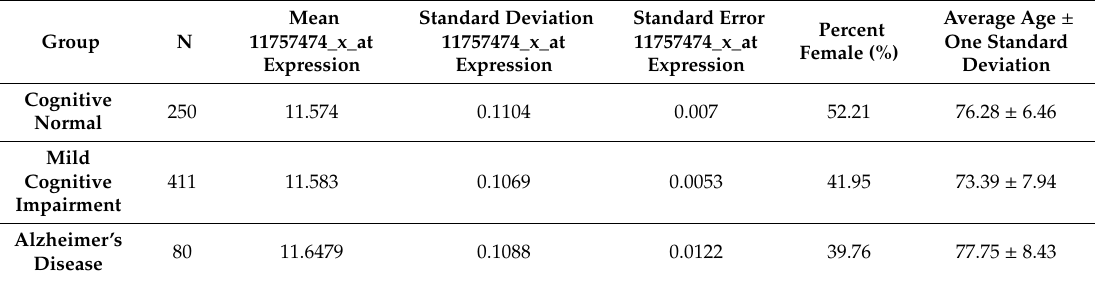
Table 1. Mean RNA expression levels for the 11757474_x_at probe. The three groups are based on Clinical Dementia Rating (CDR): cognitive normal (CDR = 0), mild cognitive impairment (CDR = 0.5), and Alzheimer’s disease (CDR ≥ 1.0). The mean RNA levels for the Alzheimer’s disease group significantly di ff ers from the other two